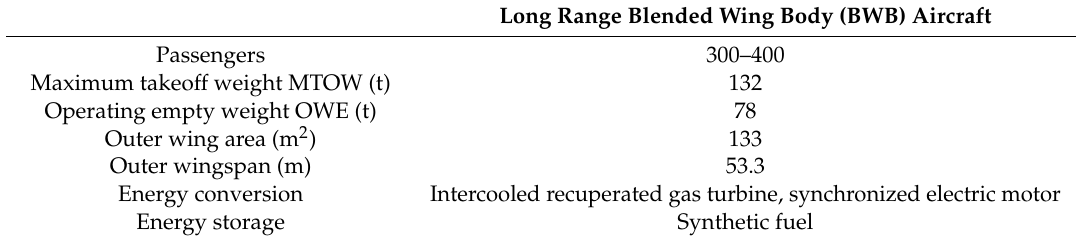
Table 1. Summary of the parameters and best technologies according to [8] for the long range BWB-design under consideration in the present